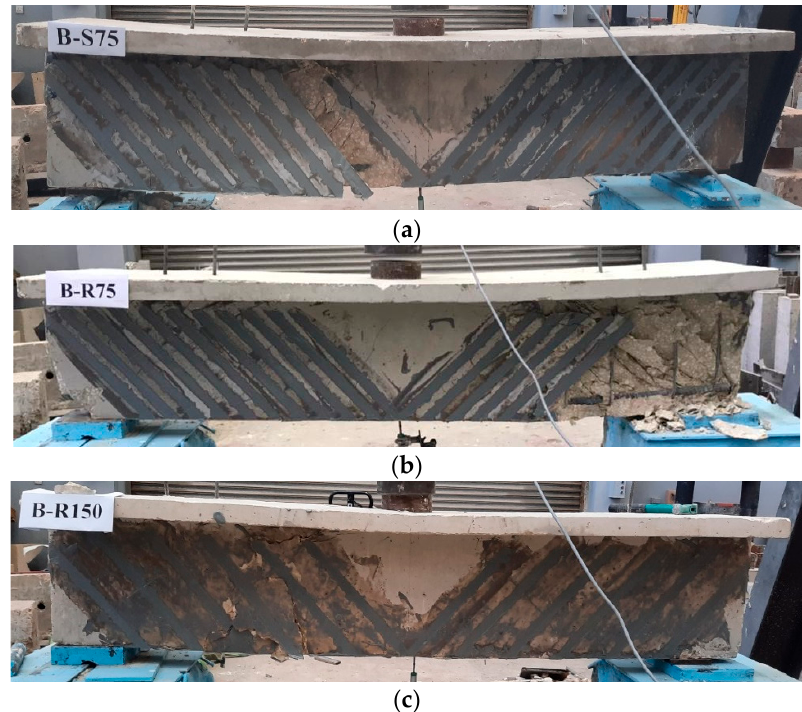
Figure 6. Failure modes of group B specimens. ( a ) B-S75 ( b ) B-R75 ( c ) B-R150.